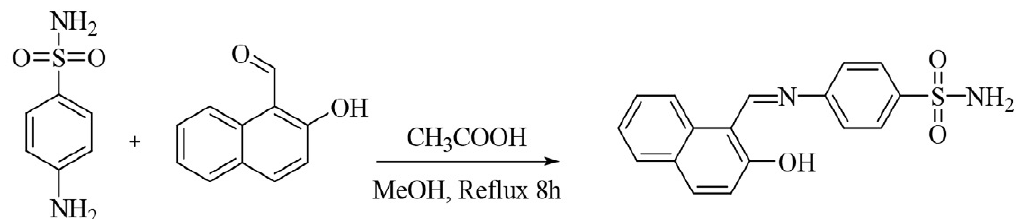
Figure 1. Synthesis of 4-[(2-hydroxynaphthalene-1-ylmethylene)amino]benzenesulfonamide ligand